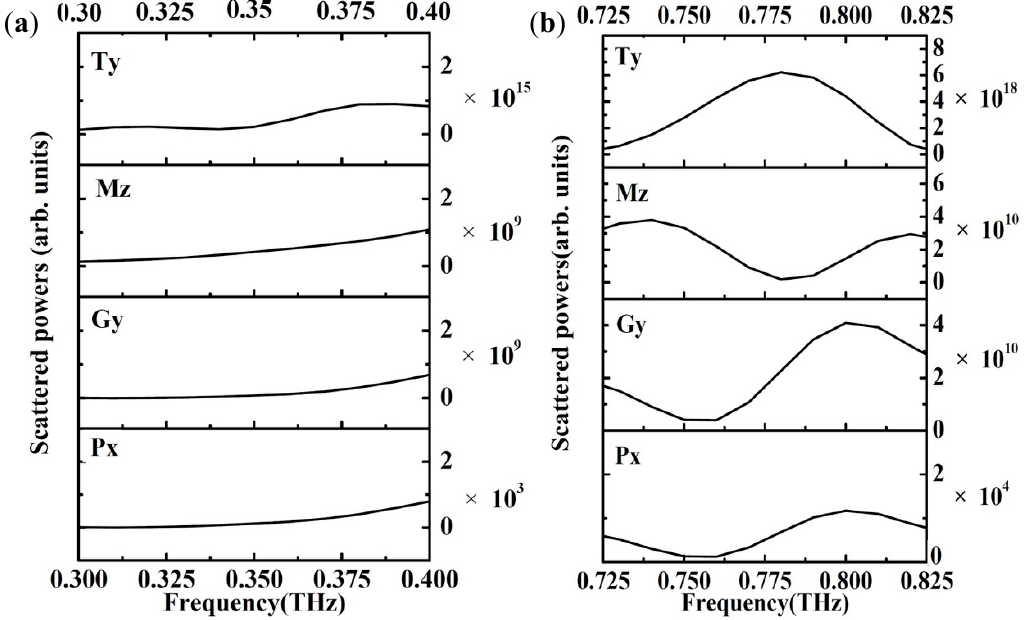
Figure 4. Decomposed scattering powers corresponding to different multipole moments (g = 10 μ m). ( a ) around LF resonance ( b ) around HF resonance.